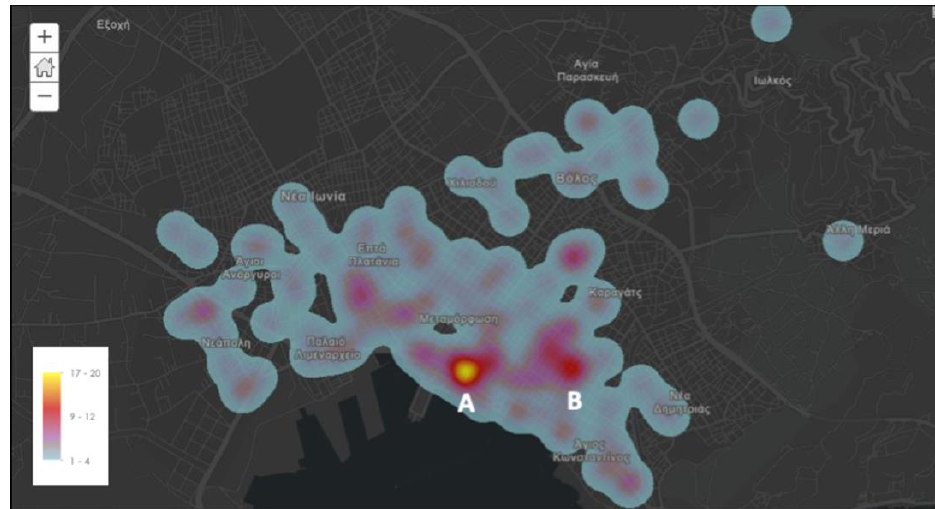
Figure 1. Heatmap of ELTA Courier delivery locations on 09.04.2019.